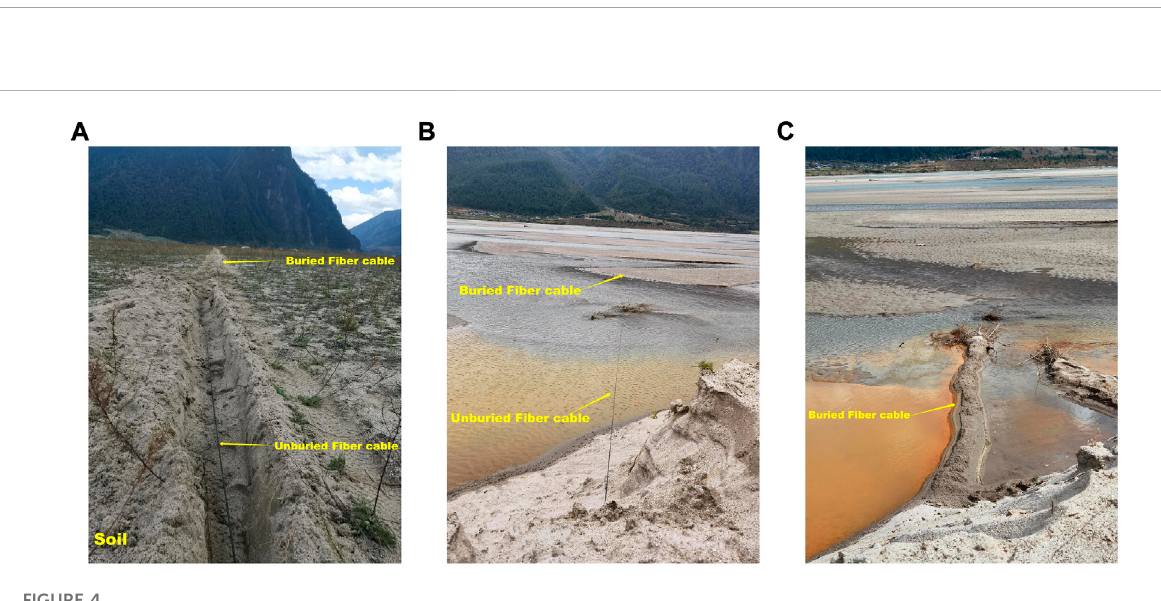
Figure 7. When seismic data are collected in the fi eld, it is inevitable to be affected by environmental and human factors, resulting in a high amplitude in the time-domain signal, as shown in the red box in Figure